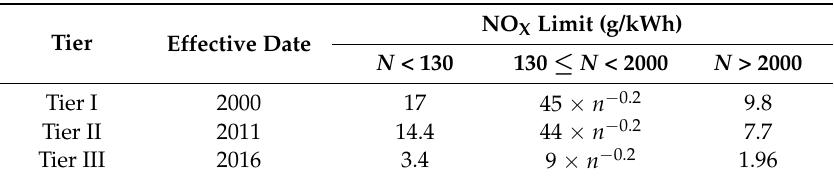
Table 1. NO x limits in MARPOL Annex